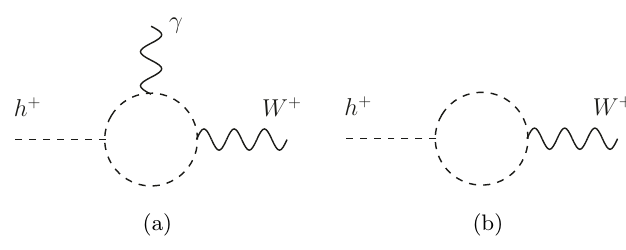
Figure 6 . The sub-diagrams of the BFZ spin suppression mechanism. When removing the photon line, only the longitudinal components of the W will contribute, because of the spin conservation.